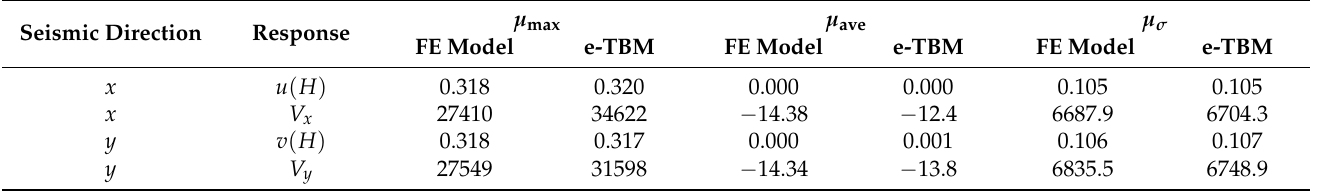
Table 5. Response statistics for the e-TBM and the FE model top displacements ( u ( H ) and v ( H ) ) and base shear ( V x and V y ). Seismic